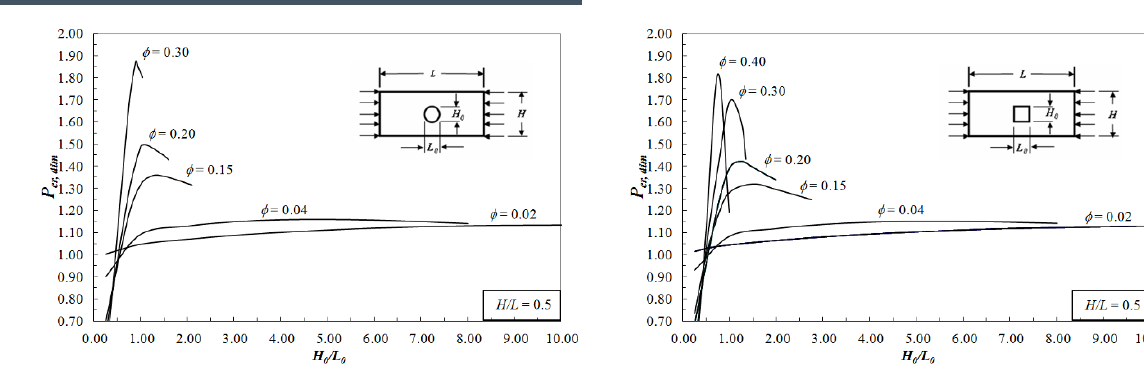
Figure 6. Plate with centered elliptical hole: optimization of the crit- ical buckling load.